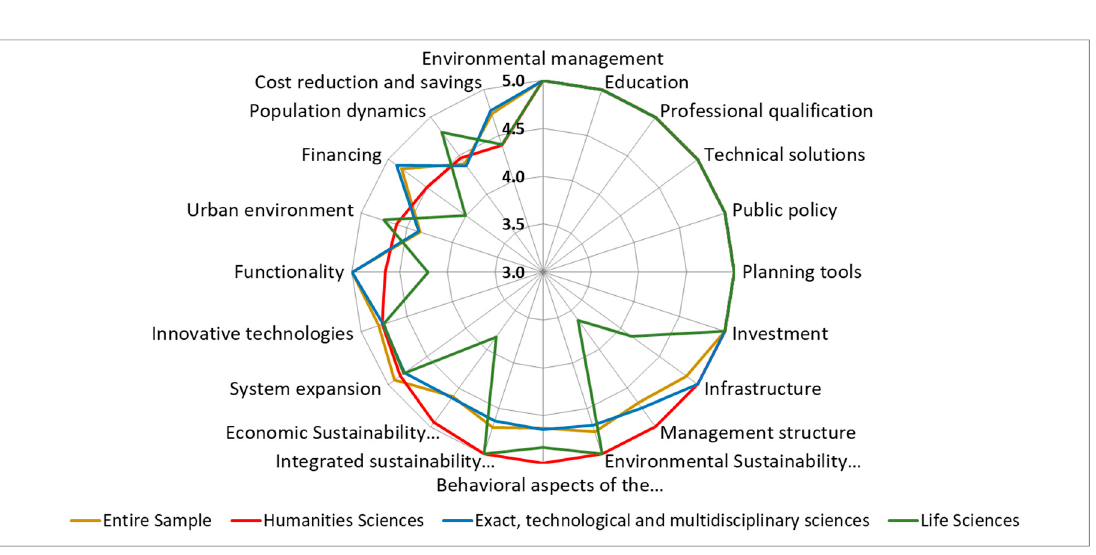
Table 2. Drivers ranked as “extremely important” by professionals who participated in the survey.